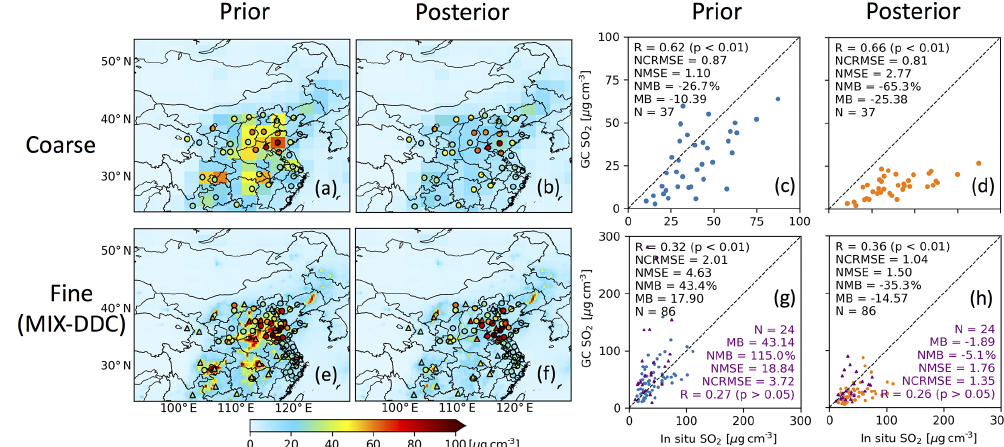
Figure 4. Evaluations of coarse-resolution, MIX-DDC GEOS-Chem surface SO 2 simulations with in situ observations for October 2013. Panels (a) and (b) show C-PRI and C-POS simulations, respectively, with in situ observations overlapped. If there is more than one ob- servation in a 2 ◦ × 2 . 5 ◦ grid cell, they are averaged. Panels (c) and (d) show scatter plots of C-PRI and C-POS simulations versus in situ observations, respectively. Panels (e) and (f) show surface SO 2 concentrations of MIX-DDC-PRI and MIX-DDC-POS, respectively, with in situ province-capital-city (triangle) and non-province-capital-city (circle) observations overlapped. Panels (g) and (h) show scatter plots of MIX-DDC-PRI and MIX-DDC-POS simulations versus in situ province-capital-city (triangle) and non-province-capital-city (circle) ob- servations, respectively. The linear correlation coefficient ( R ), normalized centered root mean squared error (NCRMSE), normalized mean squared error (NMSE), normalized mean bias (NMB), mean bias (MB), and number of observations ( N ) are shown over scatter plots, with black color text for all observations and purple color text for province-capital-city